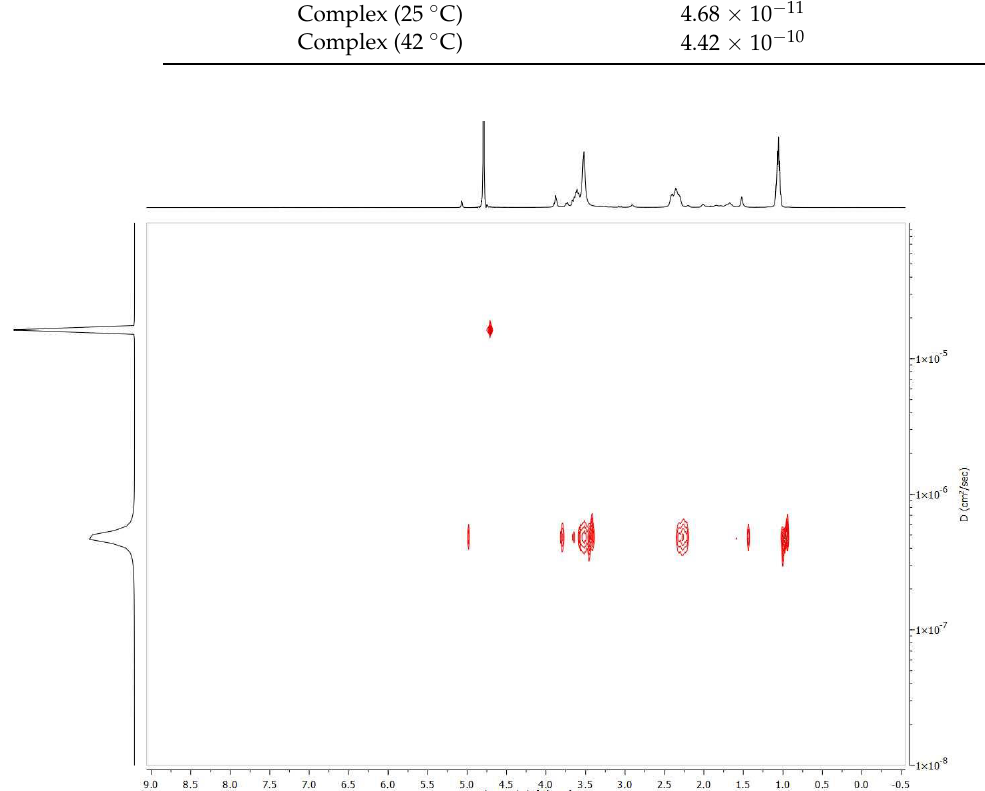
Figure 6. Two-dimensional diffusion ordered spectroscopy (2D DOSY) NMR spectrum of P(EtOx- stat -AdamantanOx) with 0.2 equivalents of β-CD at 25 °C in D 2 O.